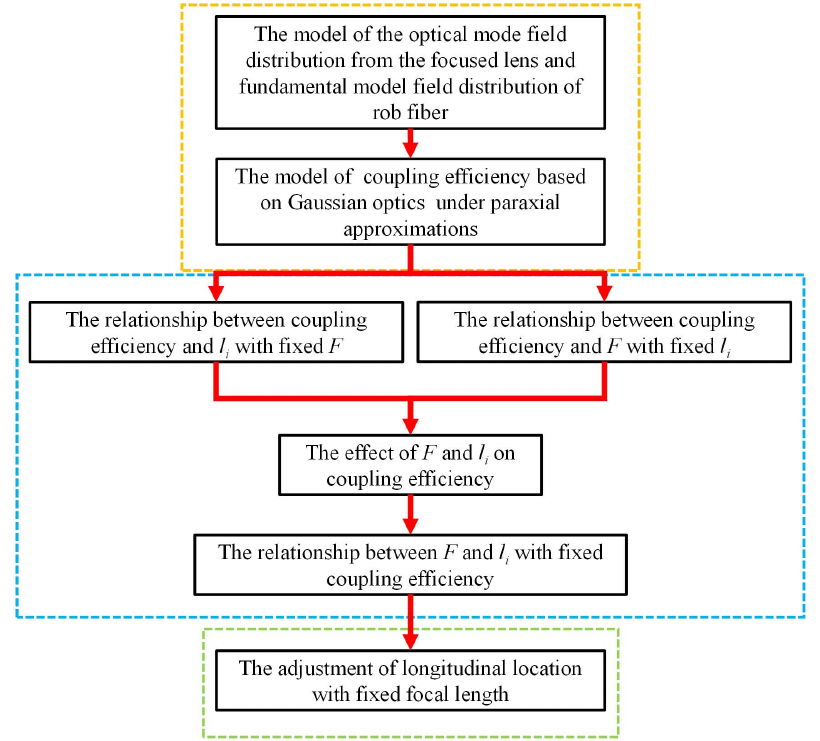
Figure 2. The scheme of the theoretical analysis.